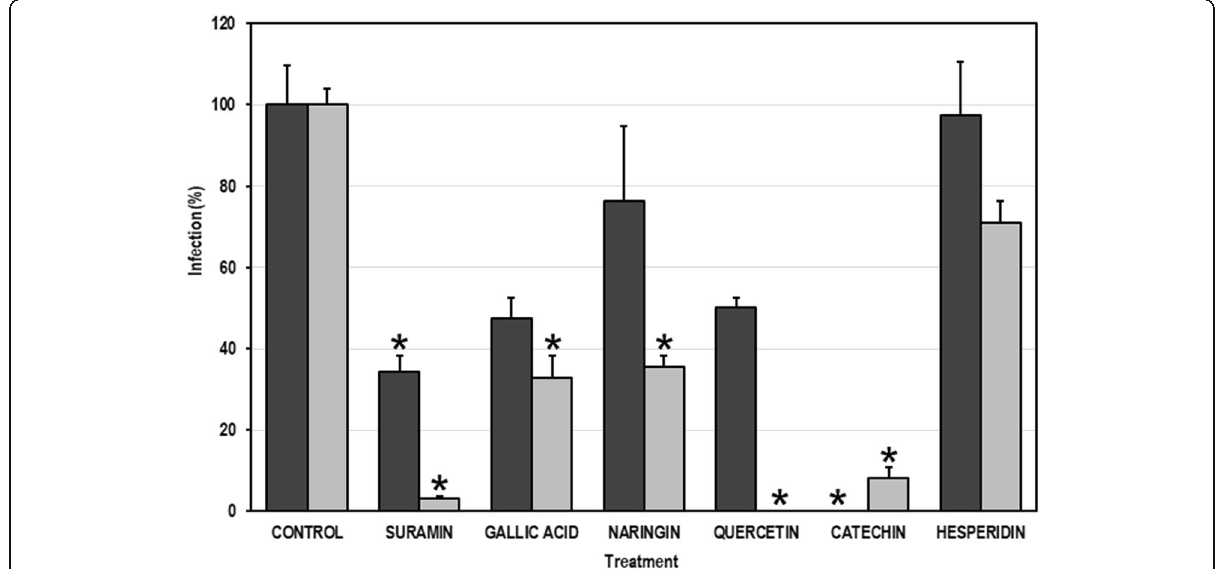
Fig. 4 Antiviral effects of the compounds derived from the Pg- YP-I-22C fraction on some steps of the DENV replication cycle. The cells were treated with the compounds for 48 h and then infected with DENV (MOI = 1). This infection strategy (pre-treatment) is represented by the dark bars. In addition, independent cell cultures were infected with DENV (MOI = 1) and then treated with the compounds (post-treatment strategy; indicated by clear bars). The error bars correspond to the SEM. The asterisks indicate cases with statistically significant differences (Student ’ s t-test; p < 0.05) in relation to the control without